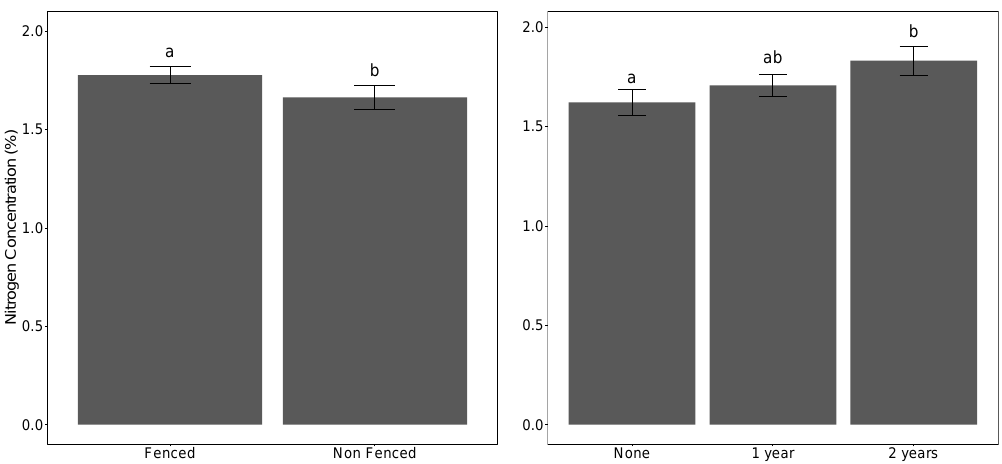
Figure 2. Mean ± SE foliar nitrogen (N) concentration (%) of Q. virginiana seedlings in 2017 after two growing seasons. Seedlings were planted in fenced or non-fenced plots and competing vegetation was not removed (None) or removed for one year or two years. Different letters indicate significant differences for each main effect, fencing and vegetation control ( α = 0.05). Seedling diameter and crown width in fenced plots increased by approximately 400% with two-year vegetation control, 300% with one-year vegetation control, and 200% with no vegetation control. After the third growing season, in fenced plots seedling height increased by 100% regardless of vegetation control, despite greater height growth the first two growing seasons in subplots with one-year and two-year vegetation control compared to subplots with no vegetation control. In non-fenced plots, regardless of vegetation control, seedlings had marginal height growth, but the diameter and crown width increased by 100% regardless of the vegetation